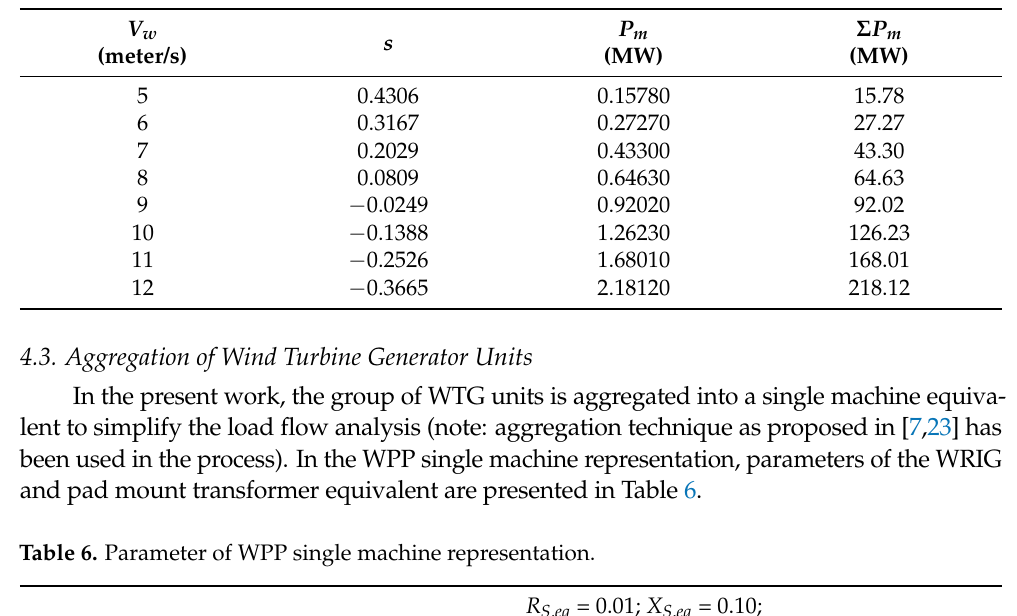
Table 5. Generator slip and turbine power.